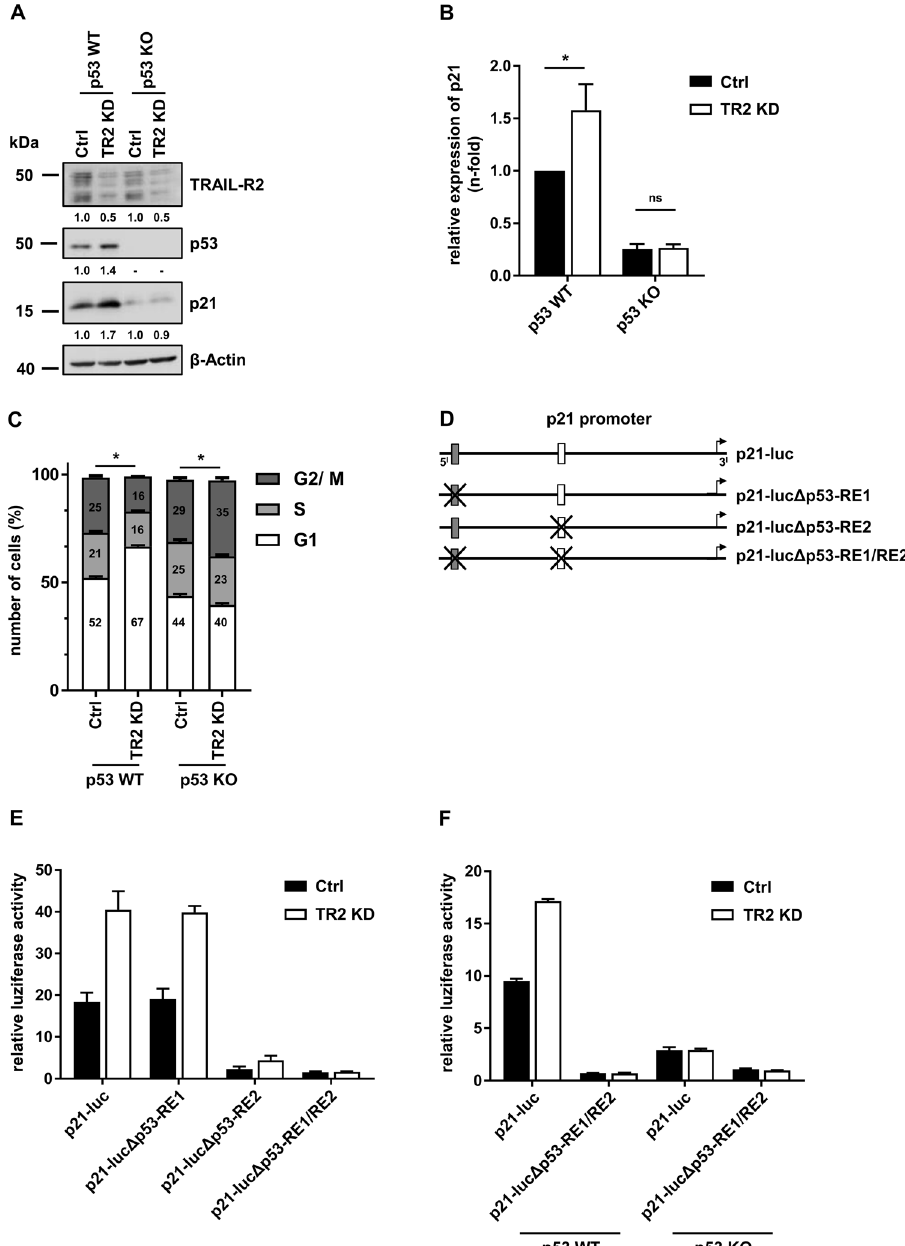
Fig. 2 TRAIL-R2 affects the p53-mediated transcriptional regulation of the p21 gene (CDKN1A). A HCT116 p53 WT and p53 KO cells were transiently transfected with TRAIL-R2 siRNA (TR2 KD) or control siRNA (Ctrl). After 48 h, protein levels of TRAIL-R2, p53, and p21 were analyzed by western blotting. The level of β -Actin was determined in parallel and served as loading control. Bands were analyzed by densitometry. Intensity of each band was normalized to the corresponding β -Actin. B Relative expression of p21 mRNA levels (normalized to TBP) were analyzed by qRT-PCR in HCT116 p53 WT and p53 KO cells, which were transiently transfected as in ( A ) for 72 h. Bar chart shows mean values ± SD of three biological replicates ( n = 3). C HCT116 p53 WT and p53 KO cells were transfected as in ( A ) and cell cycle analyses were performed 72 h later. Bar chart shows mean values ± SD of three biological replicates ( n = 3). D Schematic representation of reporter vectors used in ( E ) and ( F ). E , F HCT116 p53 WT ( E , F ) and HCT116 p53 KO cells ( F ) were transfected with siRNA as in ( A ). After 48 h, cells were additionally transfected in duplicates with plasmids containing a luciferase gene (luc) under control of the p21-promotor (with or without p53-responsive element (RE1 or 2). After 24 h luciferase activity was measured and normalized to the activity of renilla luciferase. Bar chart shows mean values ± SD of one representative experiment ( n = 1). ns, non signi fi cant; * p < TRAIL-R2 (TR2 KD) in HCT116 cells resulted in drastically extended half-life of the p53 protein (Fig. 4C, E). This effect was even more apparent in TRAIL-R2 Sup A549 cells (Fig. 4D, F). To study the mechanisms behind this phenomenon, A549 and HCT116 cells were treated with the 26 S proteasome inhibitor MG132 and protein levels were analyzed by western blot (Fig. 4G, H). MG132